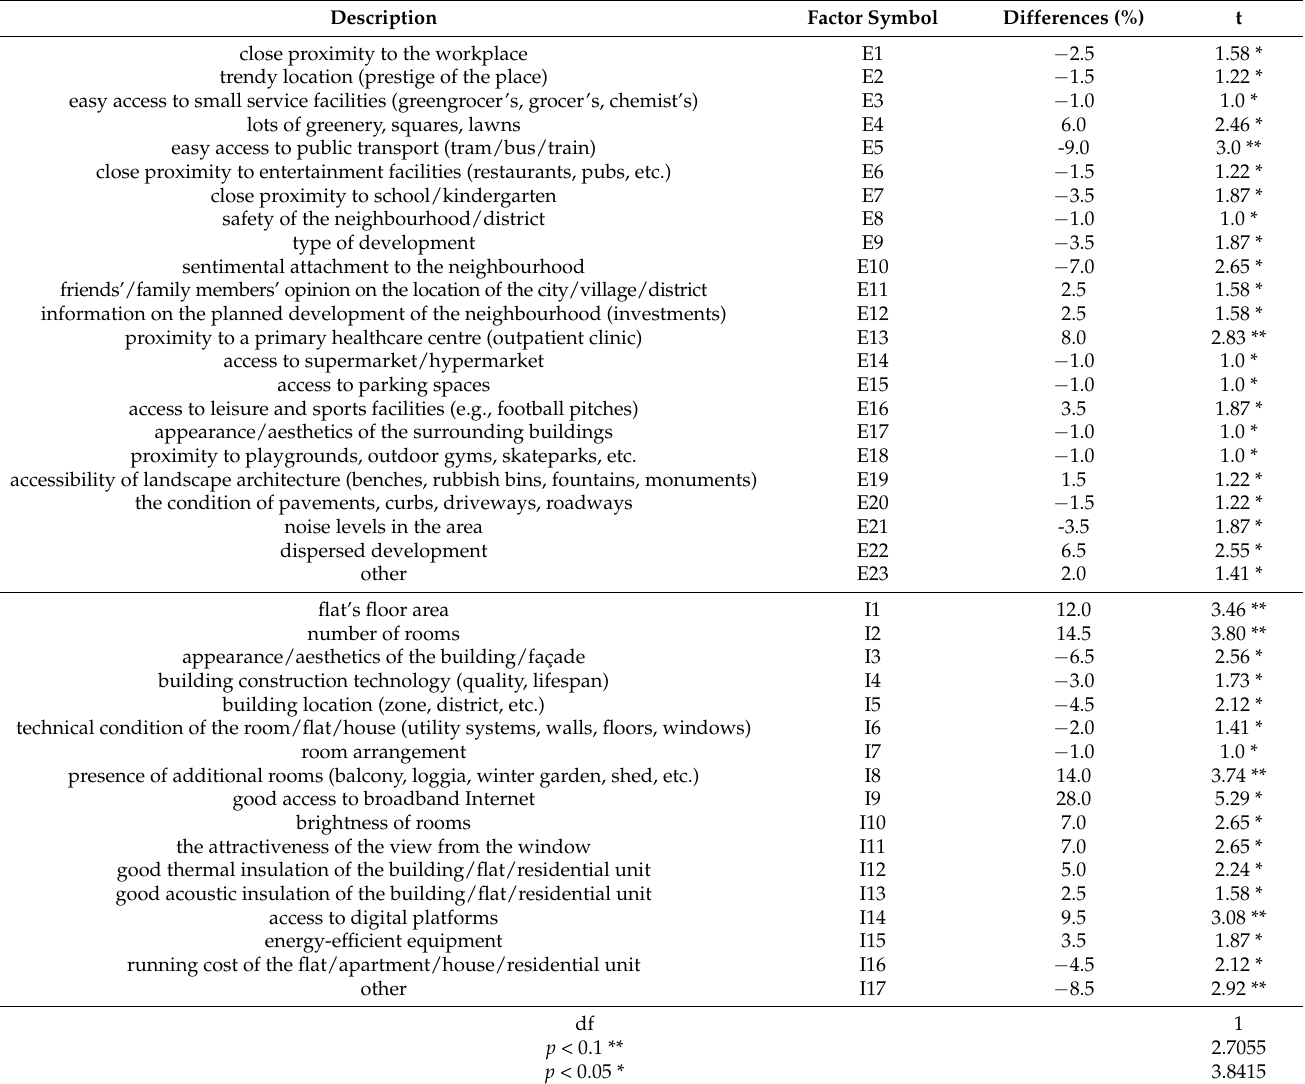
Table 3. Post-COVID-19 changes in external and internal factors (for the entire population). Description Factor Symbol Differences (%) close proximity to the